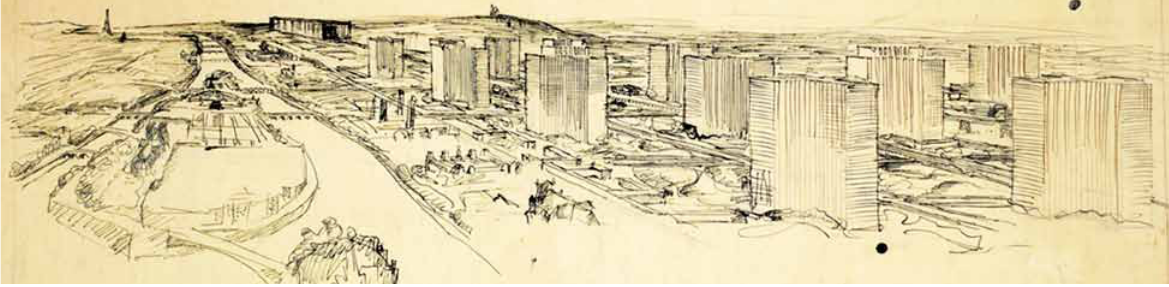
fig. 11. aerial perspective of Plan Voisin. flC 29721 © flC-aDaGP